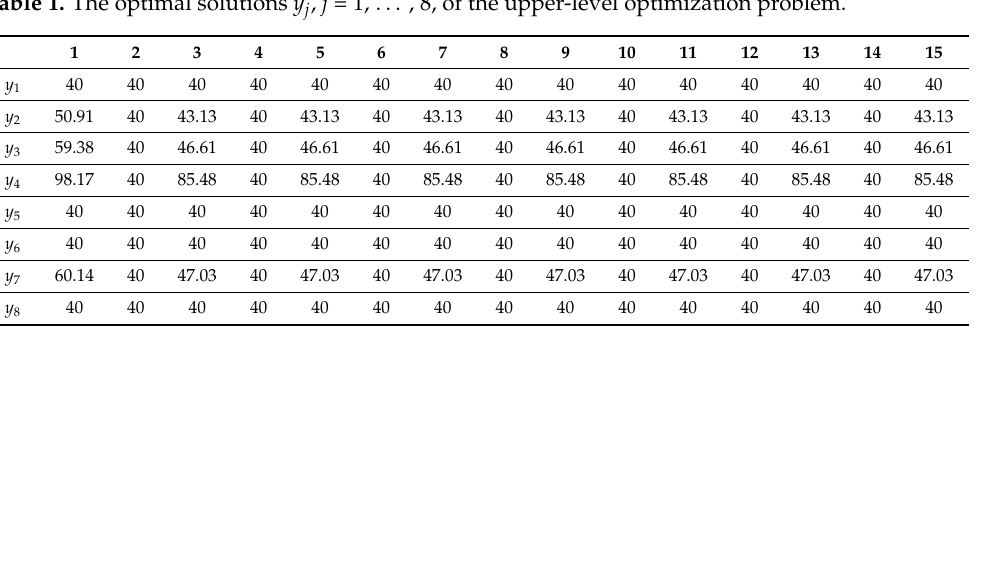
Table 1. The optimal solutions y j , j = 1, . . . , 8, of the upper-level optimization